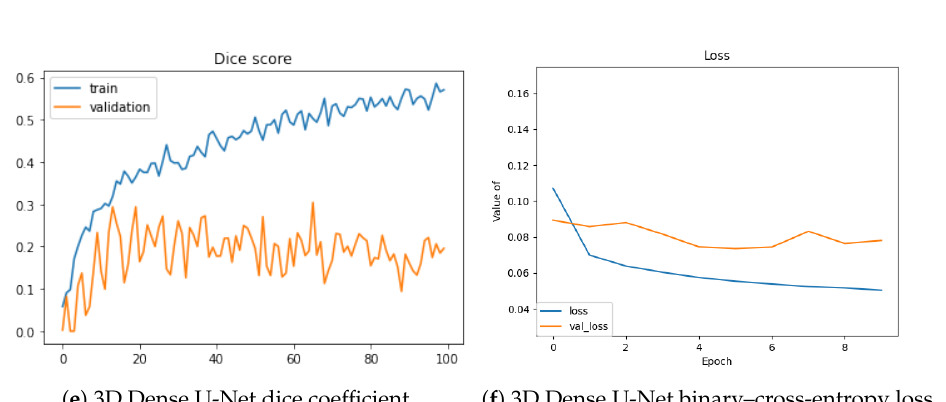
Figure 3. Training and validation Dice values per epoch for slab-based models ( a , c , e ) and loss optimization for box-based models with sliding-window averaging ( b , d , f